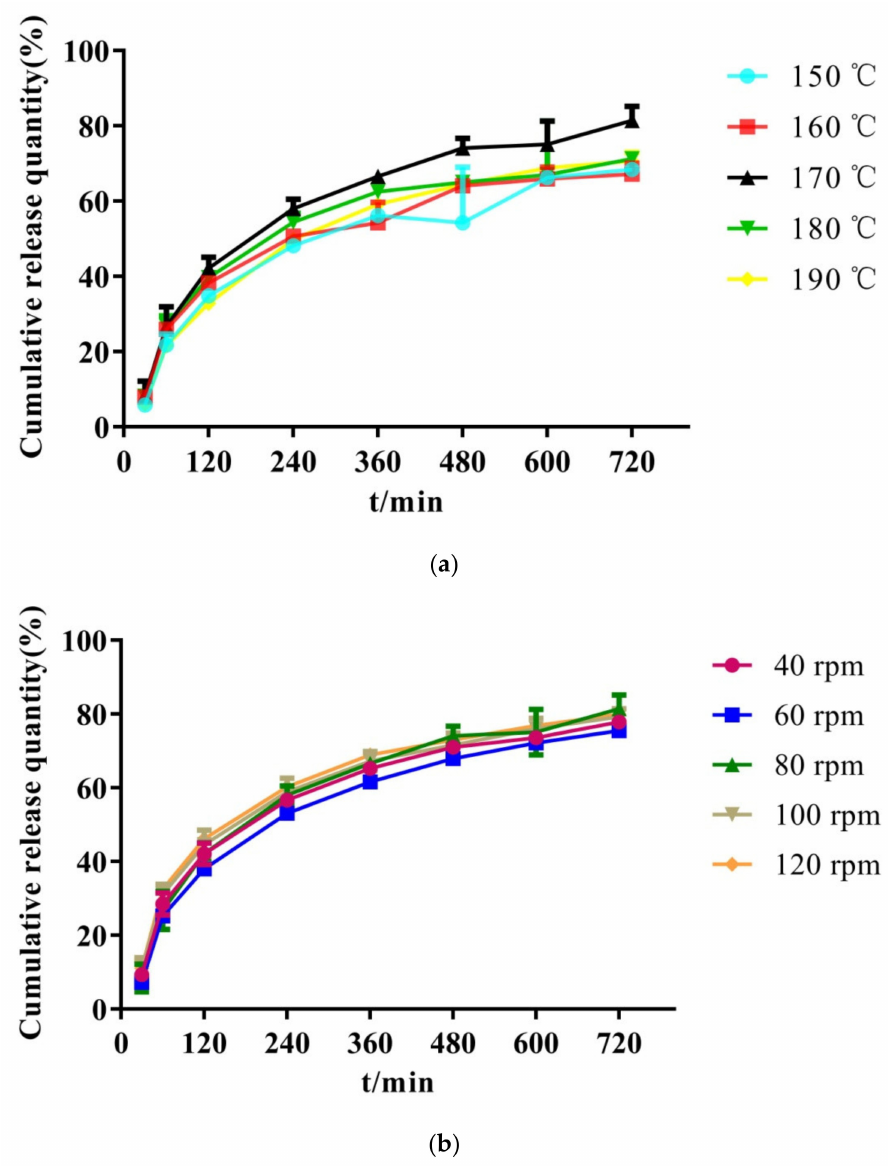
Figure 8. Dissolution curves of solid dispersion prepared by different barrel temperature ( a ) and screw speed ( b